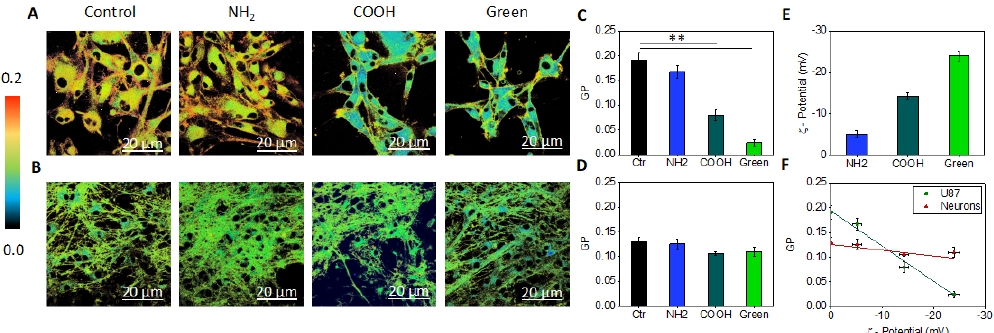
Figure 6. Membrane fluidity measured through generalized polarization (GP) of Laurdan emission for U87 ( A ) and cortical neurons ( B ). GP values measured for U87 ( C ) and cortical neurons ( D ). The ζ -potential of GQDs ( E ). Correlation between ζ -potential and GP for U87 (in green) and cortical neurons (in red) ( F ). ** p < 0.01, one-way ANOVA and Tukey post hoc test.